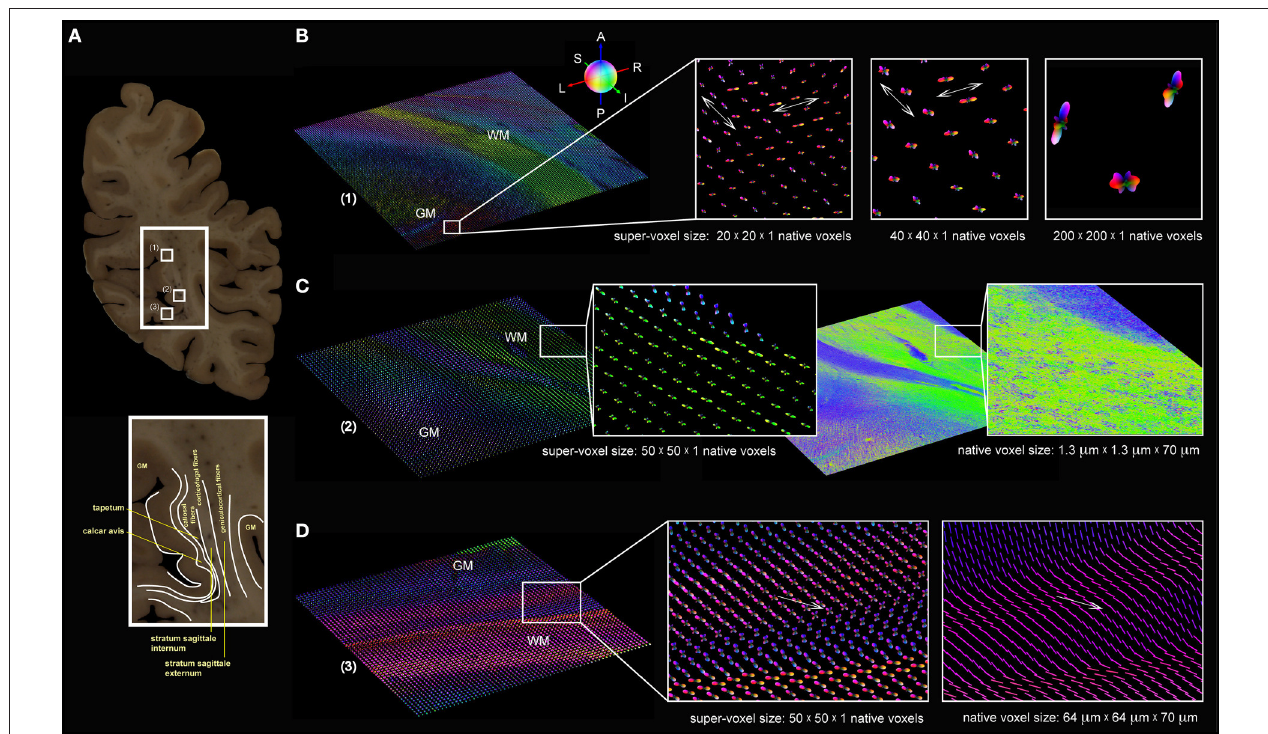
FIGURE 6 | Brain section from the human occipital lobe. (A) Segmented blockface image acquired from the surface of the frozen human occipital lobe during the sectioning process. The small white rectangles (1) to (3) indicate the selected regions of interest for which pliODFs were determined (cf. B–D ). The enlarged extract shows the delineation of anatomical structures, such as the tapetum, the calcar avis, and the stratum sagittale. (B) pliODF representations in region (1) with super-voxel dimensions of 20 × 20 × 1, 40 × 40 × 1 and 200 × 200 × 1 native voxels; the magnified images show the same cortical region, which is characterized by crossing fibers (indicated by the white arrows). The largest super-voxel size is equivalent to 260 × 260 × 70 µ m 3 and corresponds approximately to the level of high-resolution post mortem dMRI measurements. (C) Region (2) demonstrates for a super-voxel dimension of 50 × 50 × 1 native voxels the preservation of the overall fiber structure in comparison with the original high-resolution FOM obtained with the polarizing microscope. Zooming into the data reveals pliODFs with multiple fiber orientations in inhomogeneous white matter regions. (D) For region (3), pliODFs (super-voxel dimension of 50 × 50 × 1 native voxels) are opposed to the vector-based representation of the FOM of the same brain region measured with the large-area polarimeter at 64 × 64 × 70 µ m 3 voxel size. The white arrows indicate a crossing zone of fibers.